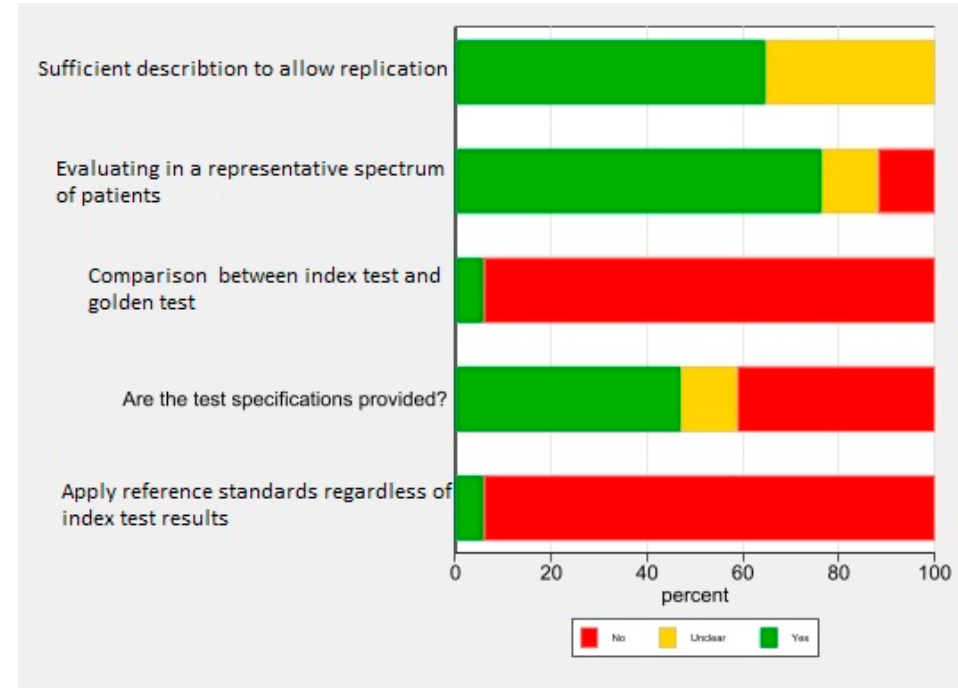
Figure 3. Critical appraisal chart.